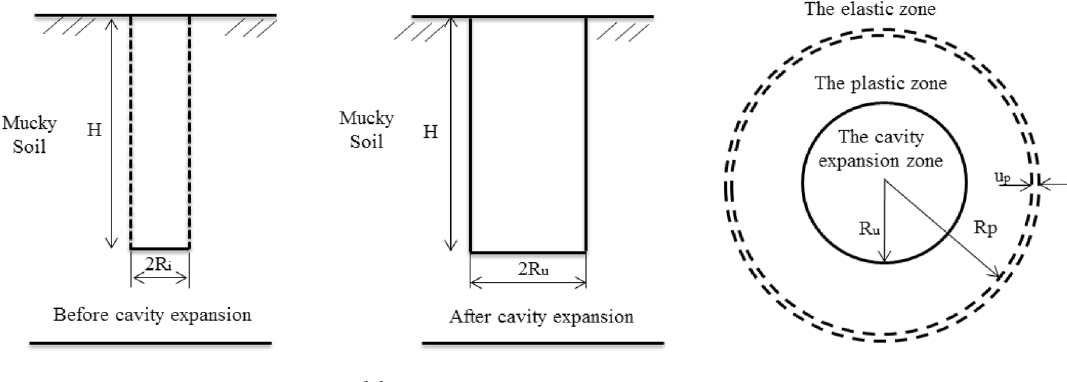
Figure 2. Cavity expansion